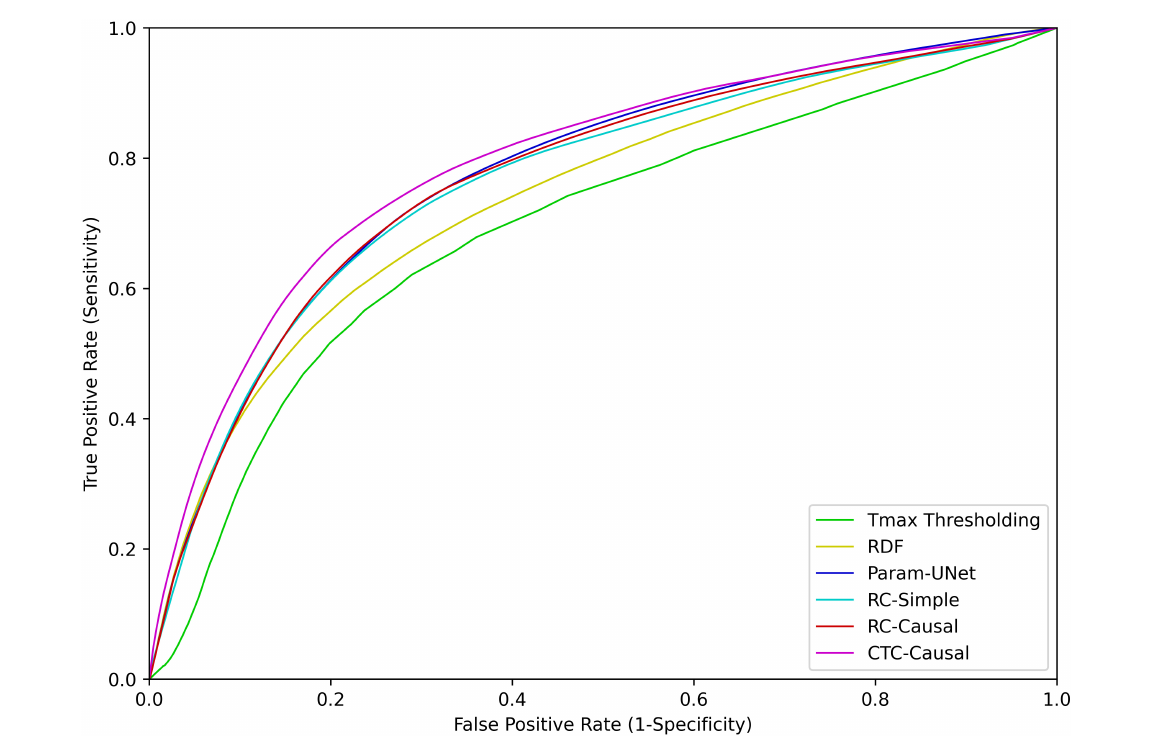
FIGURE3 Receiver operating characteristic (ROC) curves for each of the tissue outcome prediction methods. Abbreviated model names correspond to: Tmax thresholding, random decision forests (RDF), deep learning from perfusion parameter maps (Param-UNet), deep learning from deconvolved residual curves with convolutional (RC-Simple) or causal convolutional (RC-Causal) feature extraction, and deep learning from source concentration-time curves